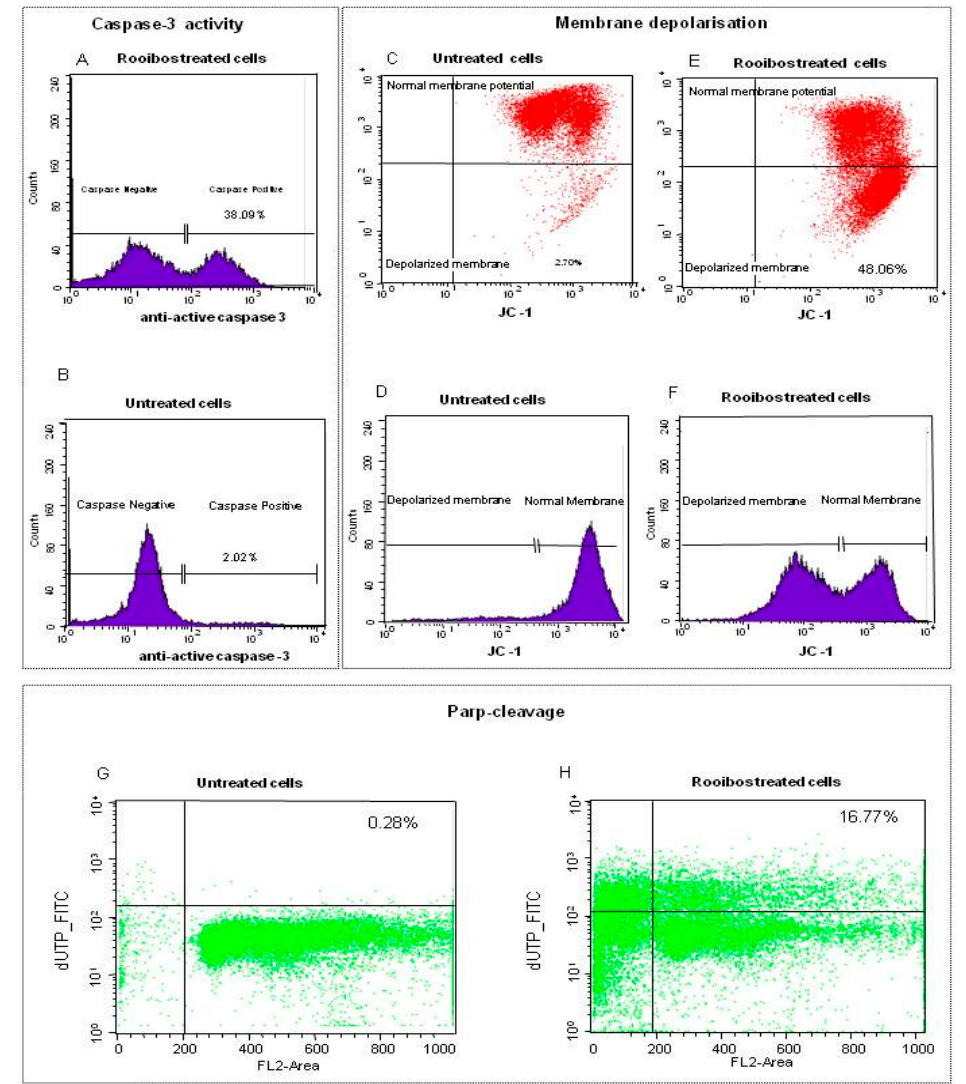
Figure 2. Flow cytometric analysis of normal cells treated with rooibos methanol extract (0.32 mg/mL). Caspase-3 activity was induced in treated cells ( A ) when compared to untreated control cells ( B ). Untreated cells also exhibited an intact polarized membrane as red fluorescent JC-1 aggregates accumulated in the mitochondria of the untreated viable cells ( C , D ), while treatment caused membrane depolarisation with JC-1 leaking into the cytoplasm ( E , F ). High concentration of non-apoptotic cells in the lower channel indicated very little DNA fragmentation in control cells ( G ). Treated cells exhibited DNA fragmentation as damaged cells were located in the upper panel while most of the cells were pro-apoptotic (sub G1; to the left of the vertical axes; ( H )). Cell towards the left of the vertical line are in sub-G1 or pro-apoptotic while most of the non-apoptotic cells were in G0/G1 (between 200 to 400 FL2 Area).